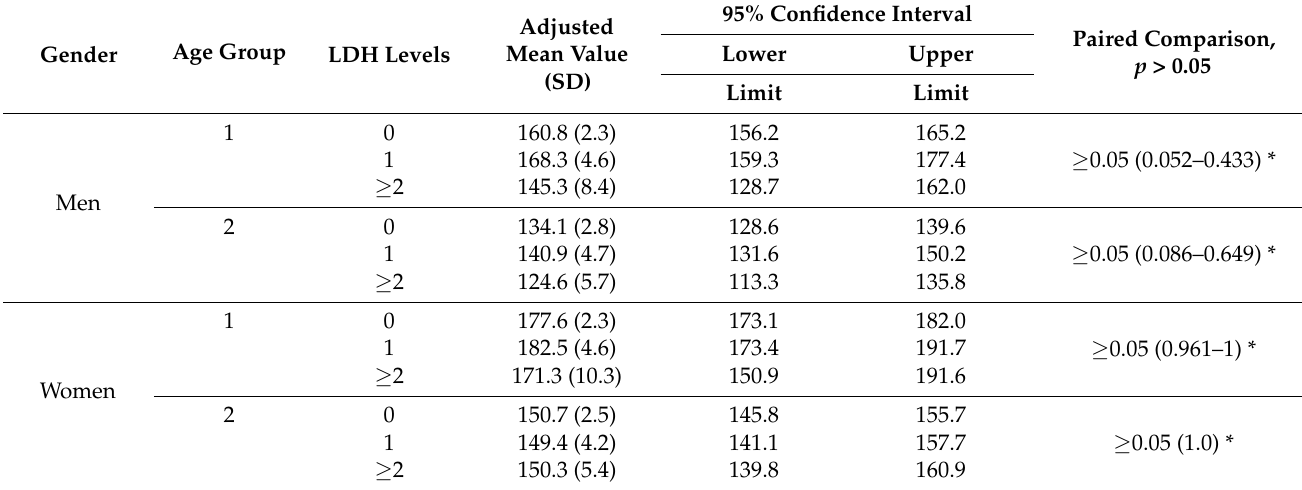
Table 4. Adjusted lumbar Trab.vBMD measurements and pair comparison within